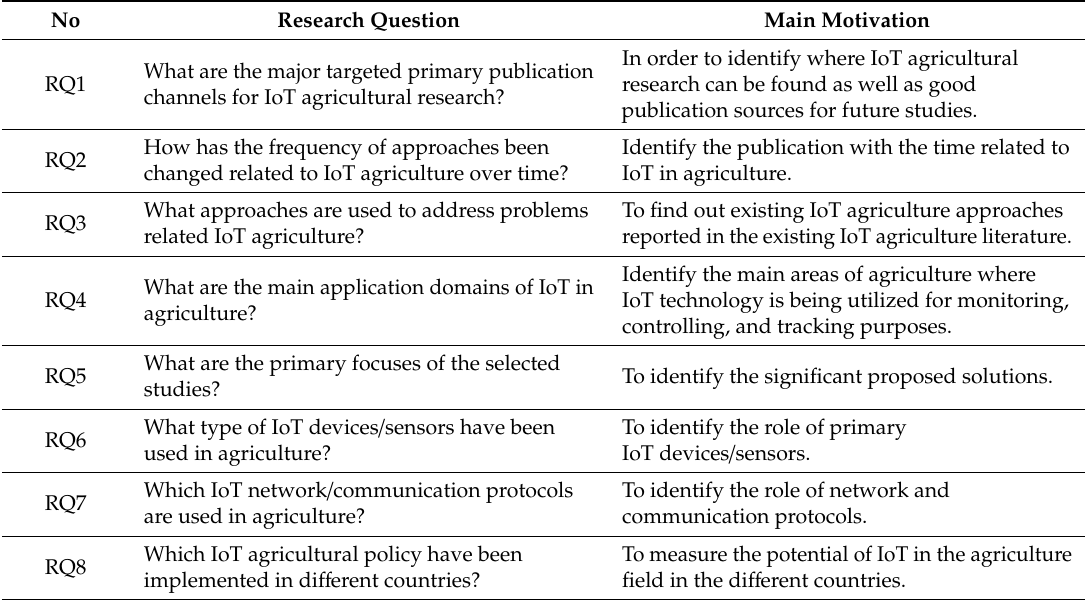
Table 1. Research questions. IoT: Internet of Things.